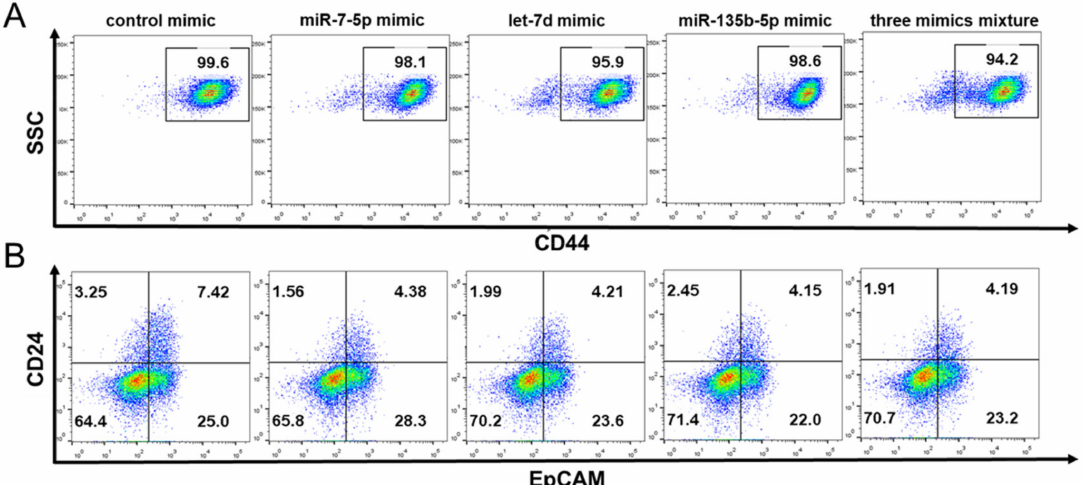
Figure 6. Flow cytometry analysis of pancreatic cancer stem cell surface markers CD24, CD44 and EpCAM in PANC-1 cells transfected with miRNA mimics. ( A ) The percentage of CD44 + cells in PANC-1 was 99.6%, transfected with miR-7-5p, let-7d, miR-135b-5p and three mixture mimics was 98.1%, 95.9%, 98.6% and 94.2%, respectively. ( B ) The percentage of CD24 + EpCAM + cells in PANC-1 was 7.42%, transfected with miR-7-5p, let-7d, miR-135b-5p and three mixture mimics was 4.38%, 4.21%, 4.15% and 4.19%,